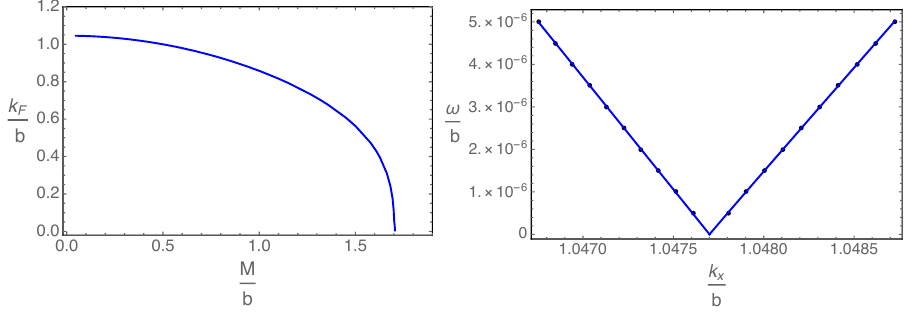
q k 2 + k 2 in the holographic NLSMs for k z = 0. In x y